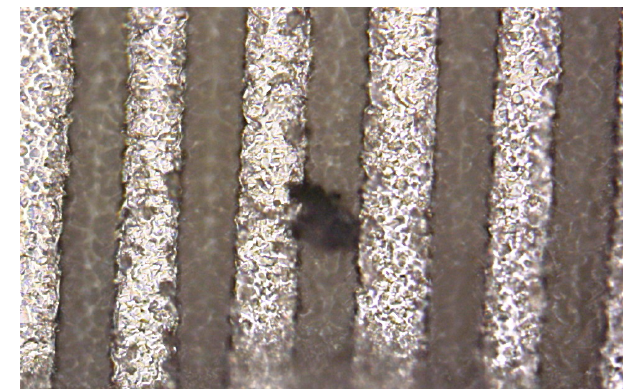
Figure 4. Single soot particle left between the platinum electrodes after a first regeneration step. The particle was removed by a second regeneration (electrode width 27.5µm).